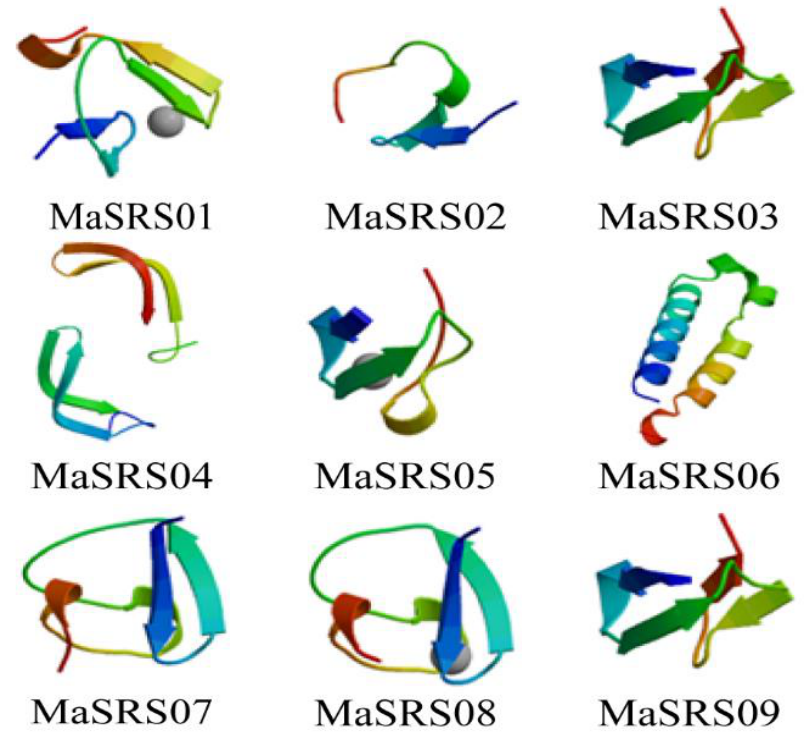
Figure 6. 3D structure prediction of SRS protein in white sweet clover ( Melilotus albus